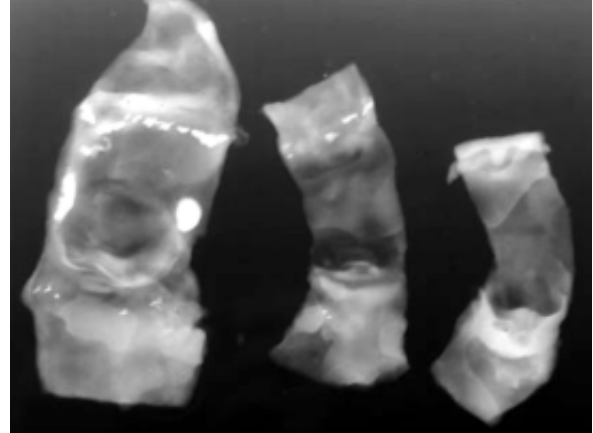
Fig. 2 - Análise radiológica dos explantes. A. Homoenxerto criopreservado com 5 meses de evolução. Observa-se pontos de calcificação na parede do enxerto na região comissural, além de calcificação nas linhas de sutura proximal e distal;. B. Homoenxerto criopreservado com 5 meses de evolução. Pode-se observar pontos discretos de calcificação próximos à base de uma das cúspides. C. Heteroenxerto decelularizado com 5 meses de evolução. Ausência completa de calcificação.